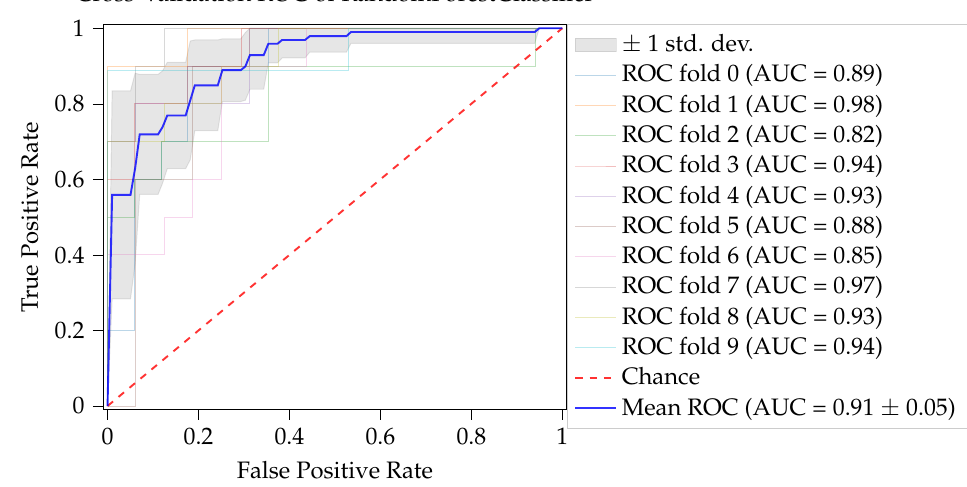
Figure 8. Different ROC Curves obtained on 10-fold cross validation test, for Random Forest.